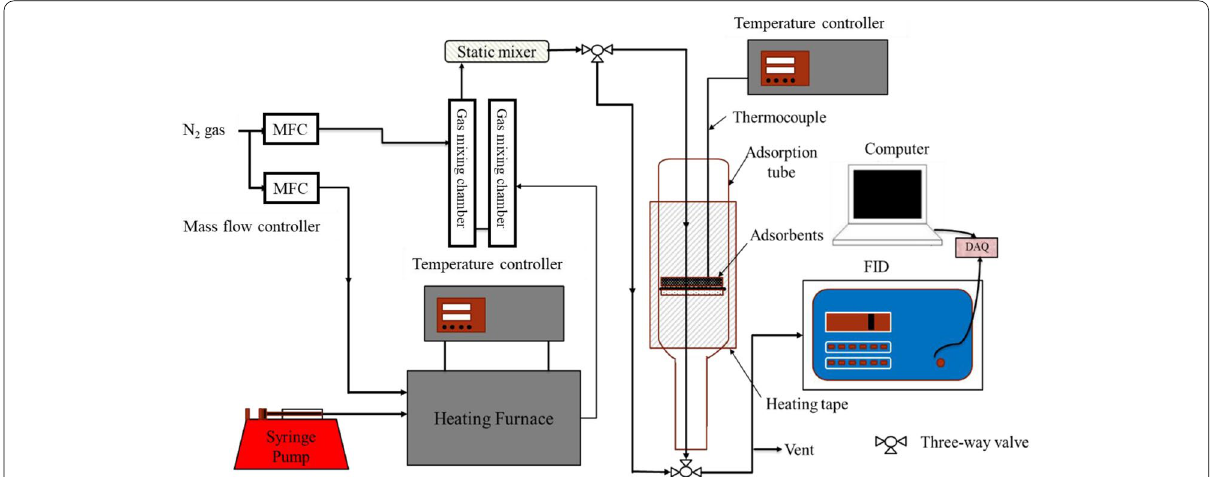
Fig. 1 VOC generation, adsorption, and data acquisition